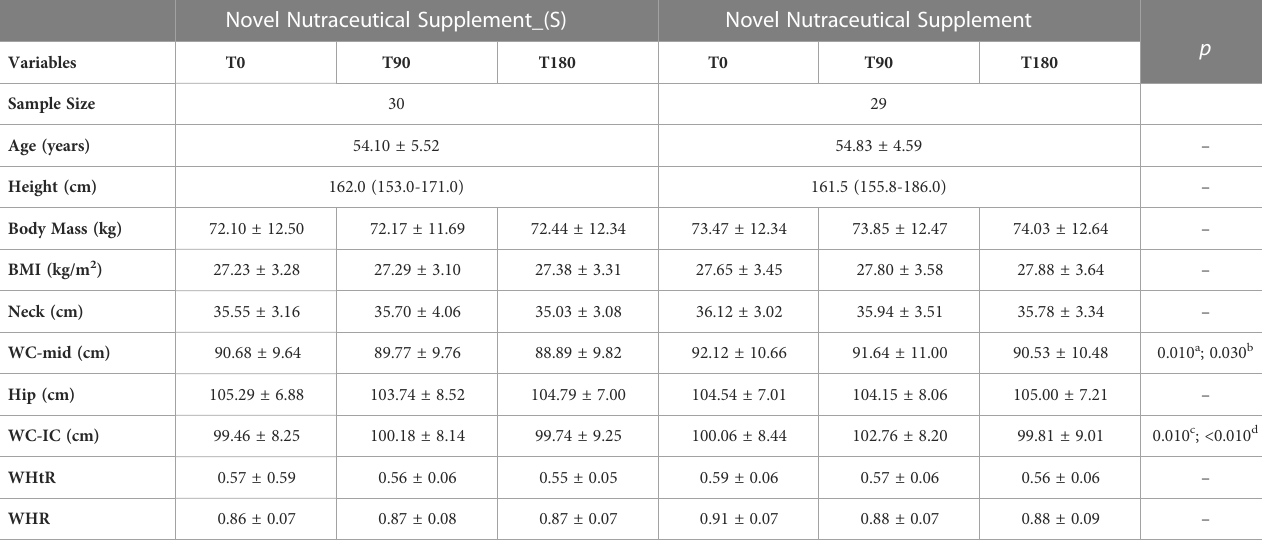
TABLE 2 Anthropometric and demographic characterization of the study population. Novel Nutraceutical Supplement_(S) Novel Nutraceutical